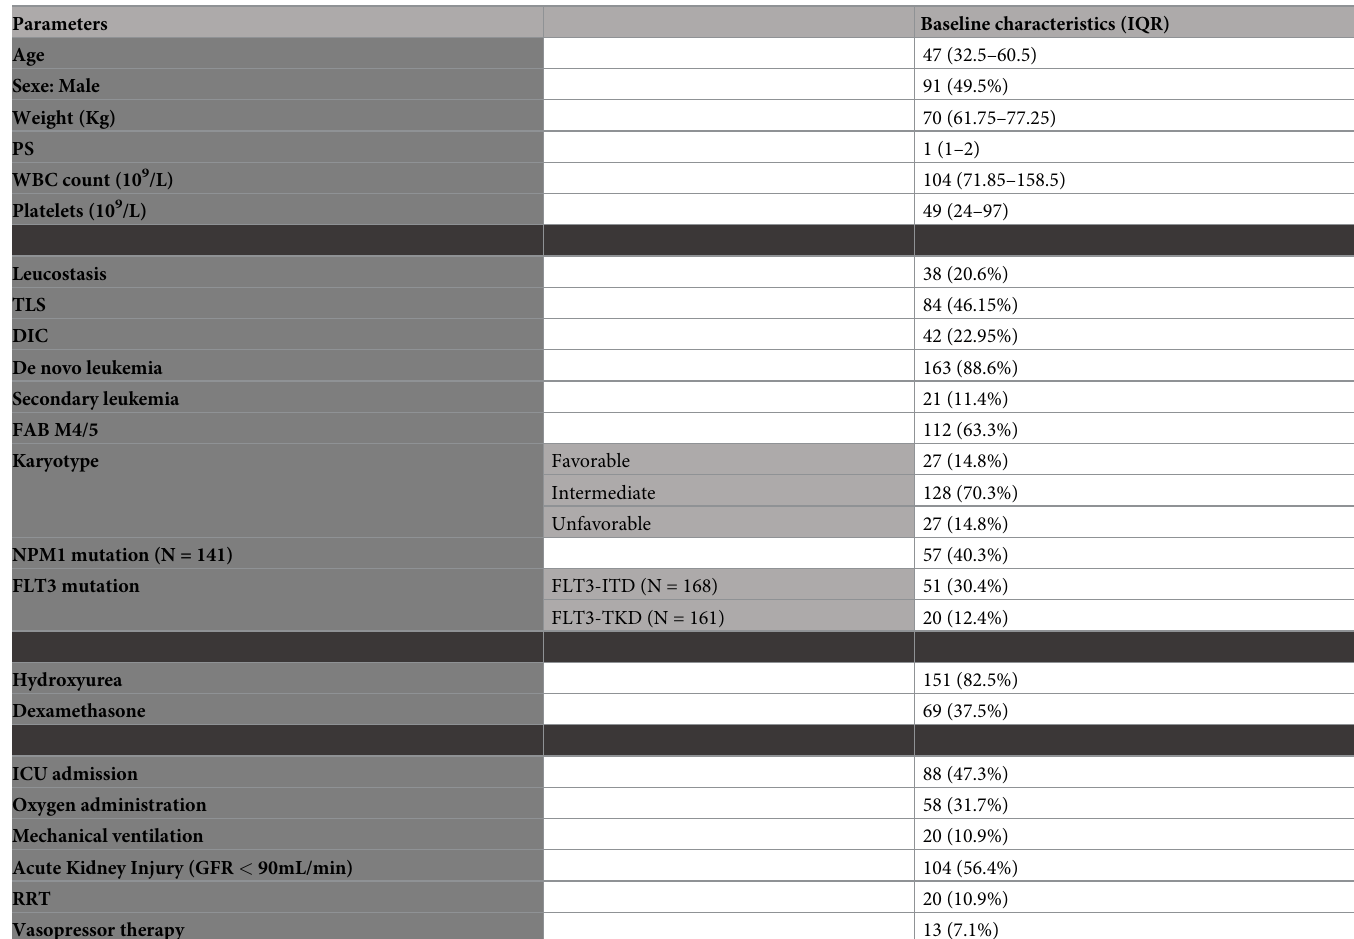
Table 1. Baseline clinical and biological characteristics of included